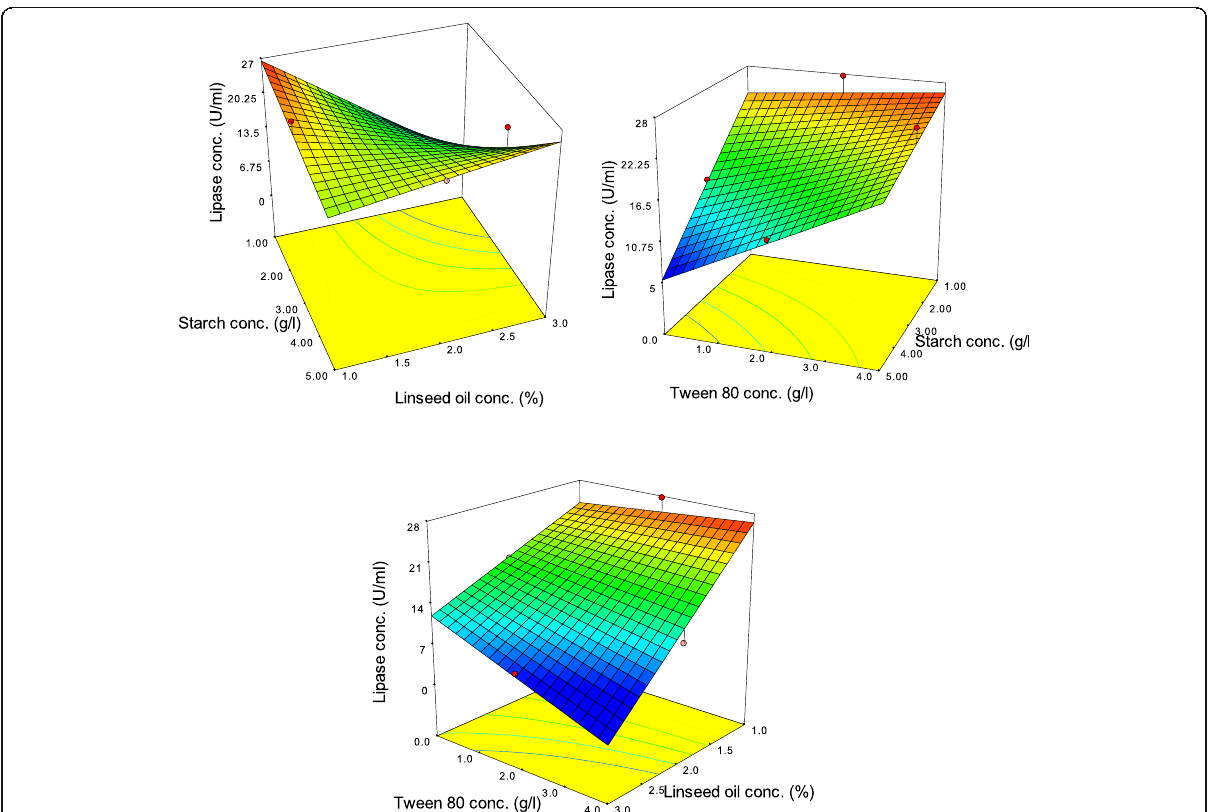
Fig. 5 The three-dimensional surface plot for the lipase production relative to a combination of two